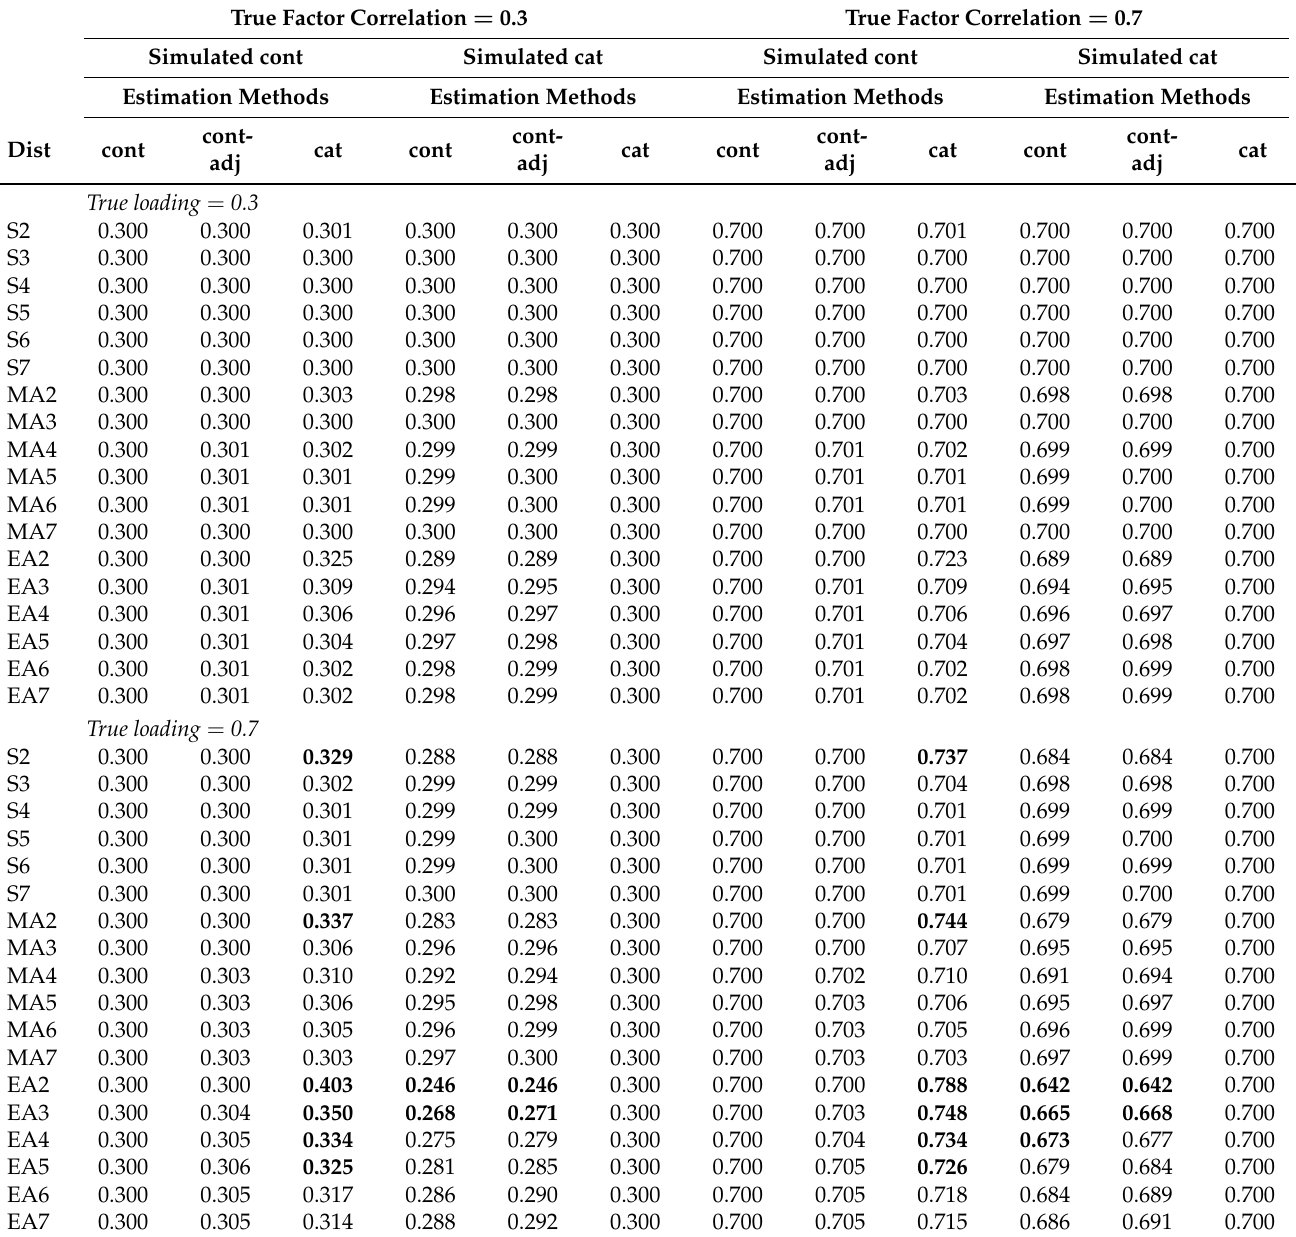
Table 2. Simulation Study 1: Estimated factor correlations as a function of data-generating models, estimation methods, true factor loadings, and true factor